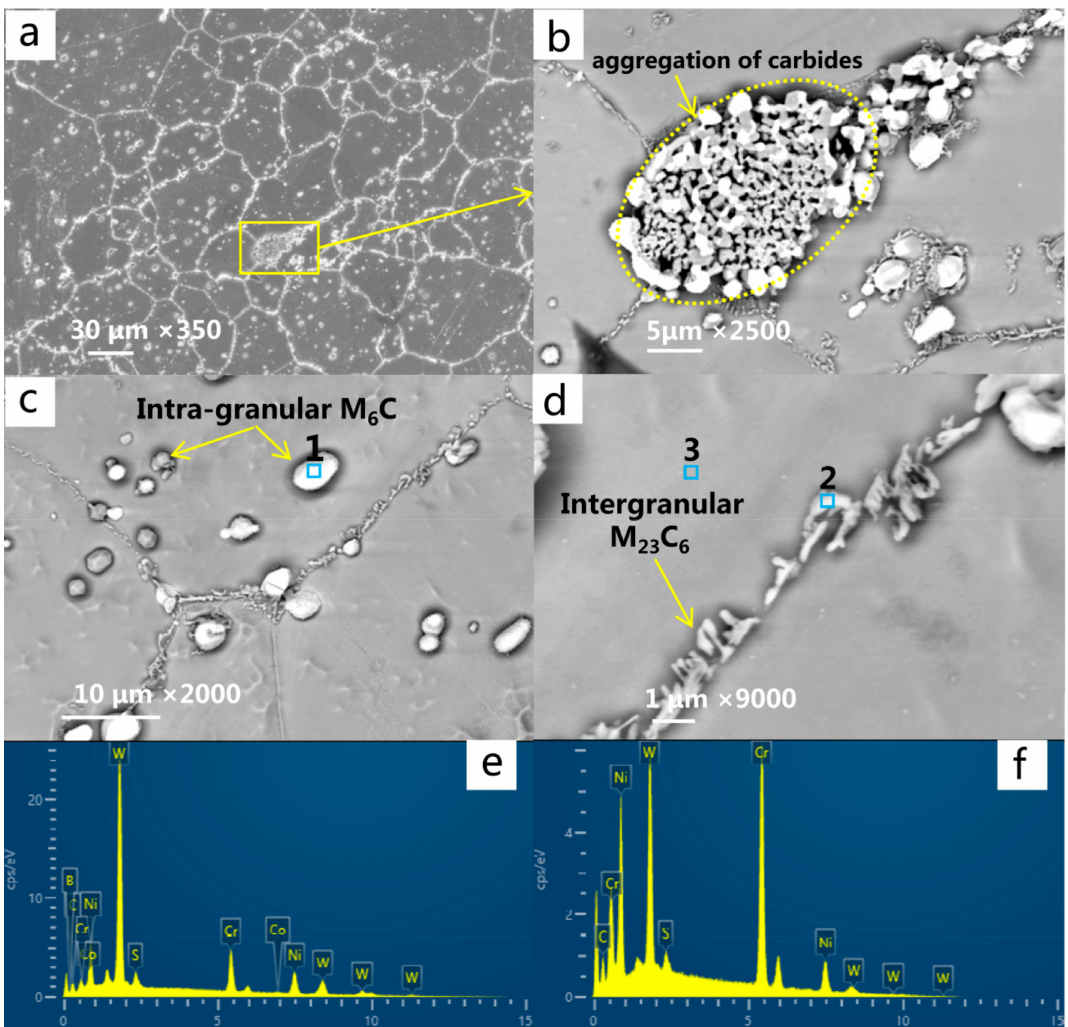
Figure 1. Scanning electron microscope (SEM) images of the microstructure of the GH3230 superalloy: ( a ) microstructure and morphology; ( b ) segregation and aggregation of intergranular carbides; ( c ) morphology and distribution of M 6 C-type carbides in grains; ( d ) morphology and distribution of M 23 C 6 type between the grains; ( e , f ) the results of the EDS analysis at positions 1 and 2 in the figure,